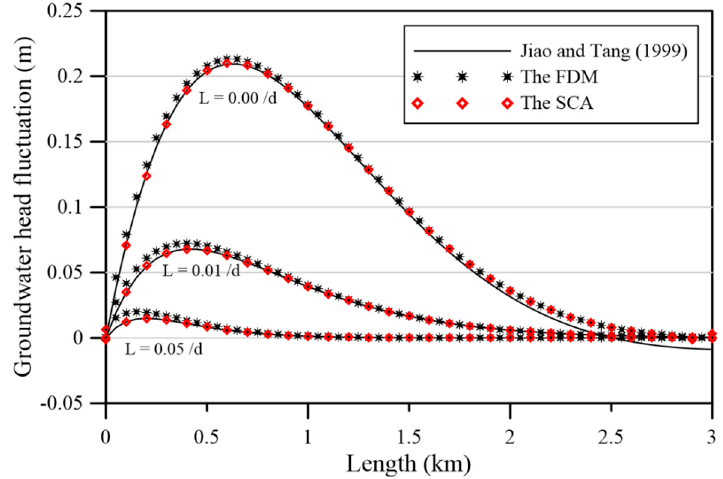
Figure13. Comparisonofthegroundwaterheadfluctuationcomputedwithpreviousstudies( tf = 6 hr). Table 2. The MAE of the finite di ff erence method (FDM) and the spacetime collocation approach (SCA). Time